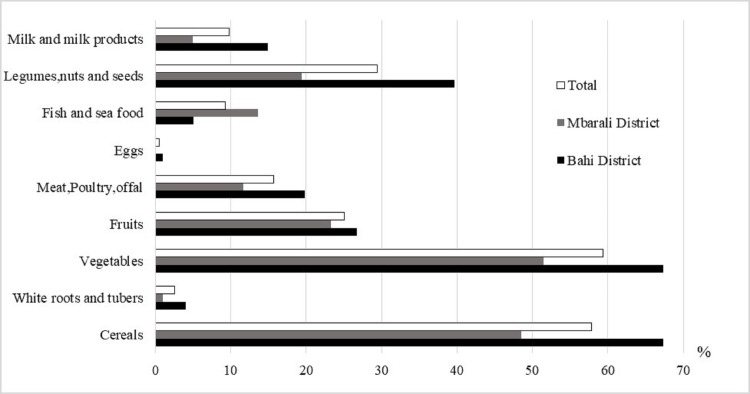
Percentage of children under 5 years who consumed each food group in 2015.